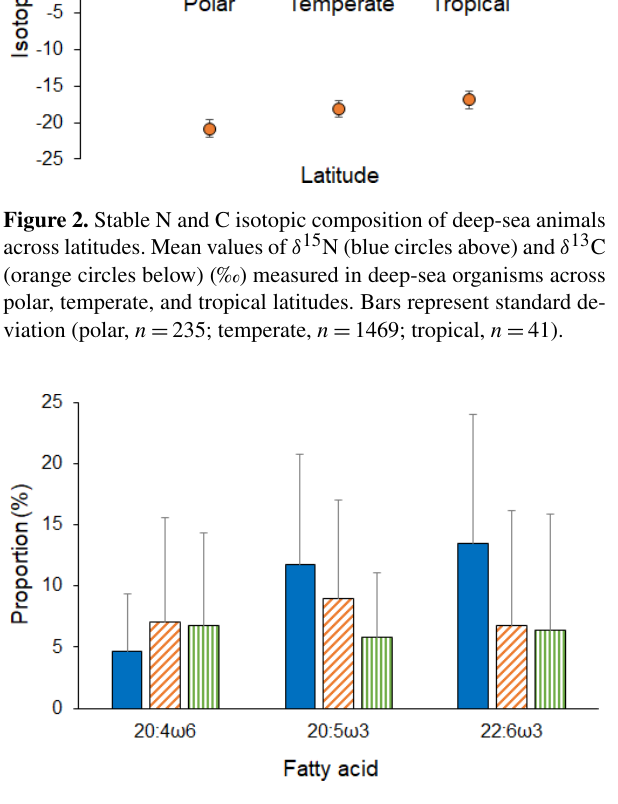
Figure 3. Essential FA composition of deep-sea animals across lat- itudes. Mean proportions of essential FA measured in the tissues of deep-sea animals from polar (blue bars), temperate (orange di- agonal striped bars), and tropical (green vertical striped bars) lati- tudes. Bars represent standard deviation (polar, n = 176; temperate, n = 227; tropical, n =